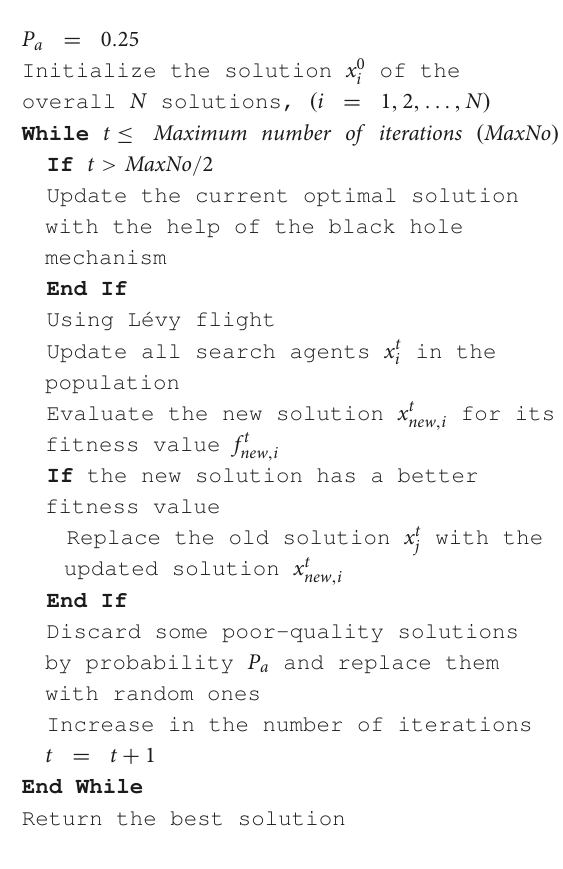
Algorithm 2. Pseudo-code of